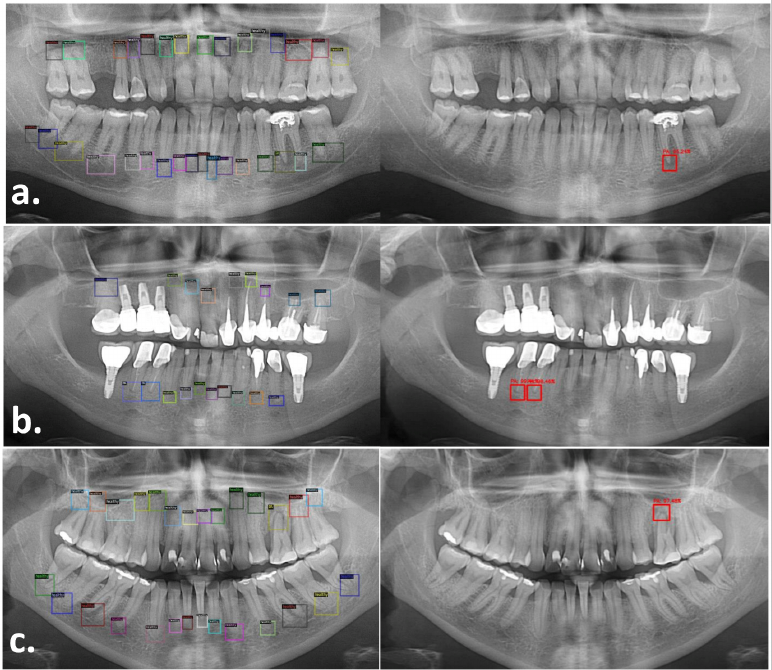
Figure 4. Performance of the proposed AI system for periapical lesion detection. This figure shows OPGs of three different cases ( a – c ) labeled by the clinician (left) and the AI (right). For each row, the OPG on the left shows the boxes annotated by the expert including PL and healthy PRAs, while on the right, we show the same OPG labeled by the AI with red boxes indicating the PL detected by the AI. The confidence score calculated by the AI system can be found on top of each red boxes. Case “( a )” shows a periapical lesion detected in a multirooted tooth (#36). Case “( b )” shows two periapical lesions in teeth with root canal treatments and crowns in a patient with dental implants. Case “( c )” shows a case with a single PL in a multirooted tooth